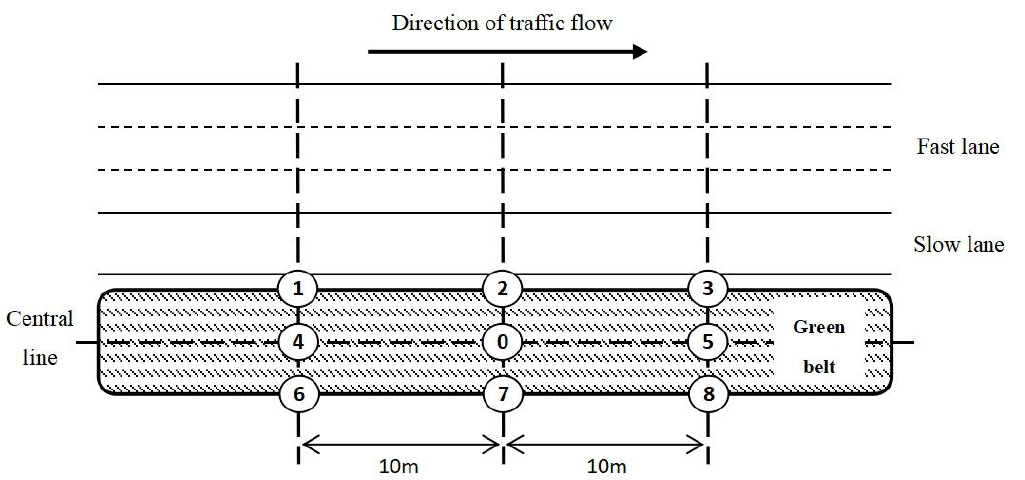
Figure 3. The schematic map of sound meter’s positions. The numbers 1–8 represent the positions of noise meters, and the number 0 represent the geometric center of the plot.